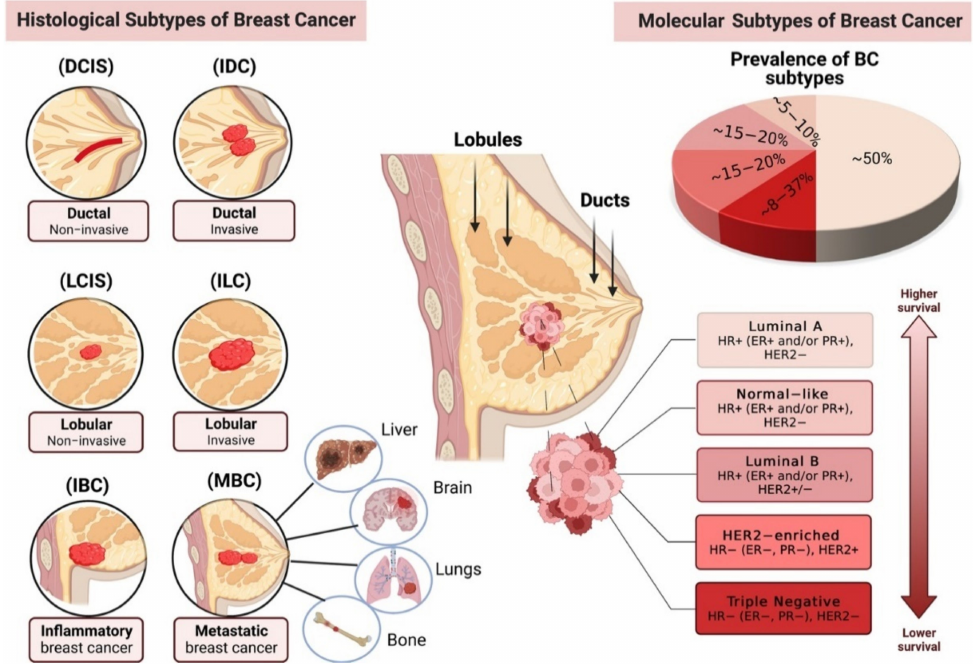
Figure 1. Main histopathological ( left ) and molecular ( right ) subtypes of breast cancer (BC). (DCIS— ductal carcinoma in situ, IDCS—invasive ductal carcinoma, LCIS—lobular carcinoma in situ, ILC— invasive lobular carcinoma, IBC—inflammatory breast cancer, MBC—metastatic breast cancer, HR—hormone receptors, ER—estrogen receptor, PG—progesterone receptor, HER2—human epi- dermal growth factor receptor) [3,17,22,25]. Figure created using BioRENDER.com. Accessed on 13 March